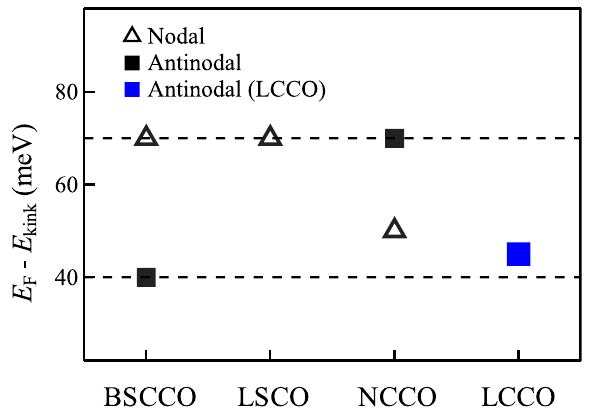
Fig. 5 Comparison of the kink energies. The energy scales of the kinks along the nodal direction (empty triangle symbols) and near the antinodal region (solid square symbols) in the hole- and electron-doped cuprates. The dashed lines at 40 and 70 meV represent the characteristic energies of the kinks. In LCCO, the nodal kink is disappeared, but the antinode has a universal kink at ~ 45 meV (indicated as the blue